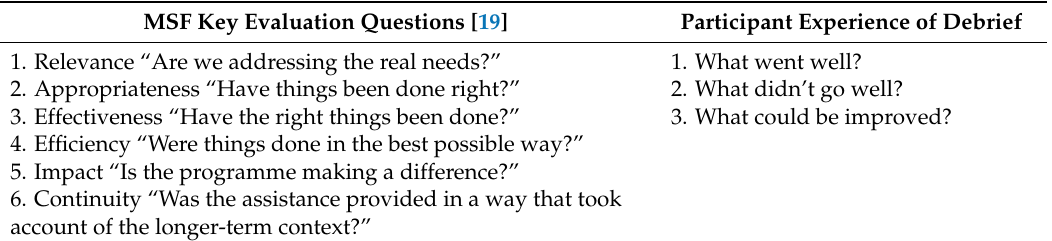
Table 2. Comparison of M é decins Sans Fronti è res (MSF) Evaluation Framework [19] with participant